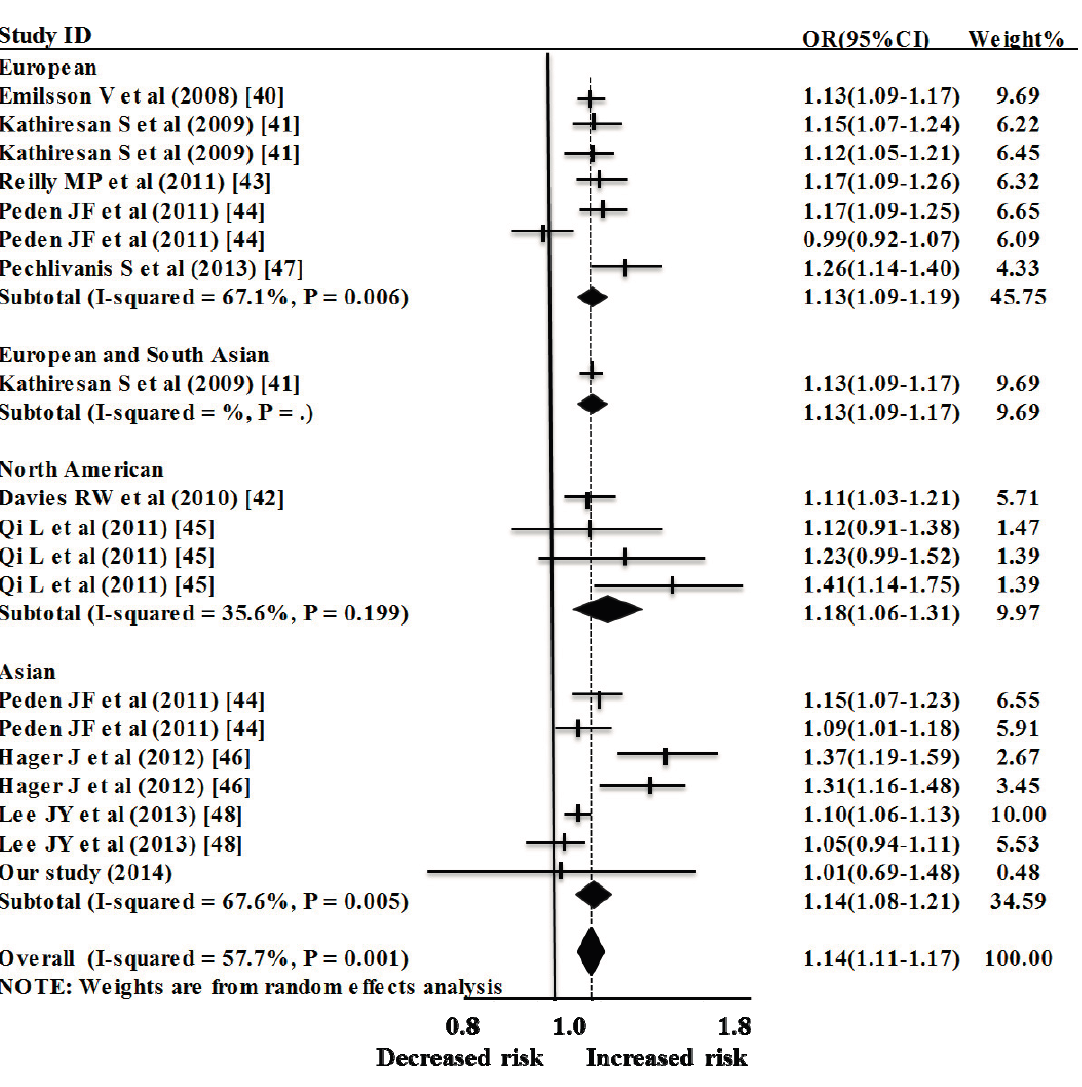
Figure 3. Meta-analysis of the association between rs12526453 and CAD risk stratified by